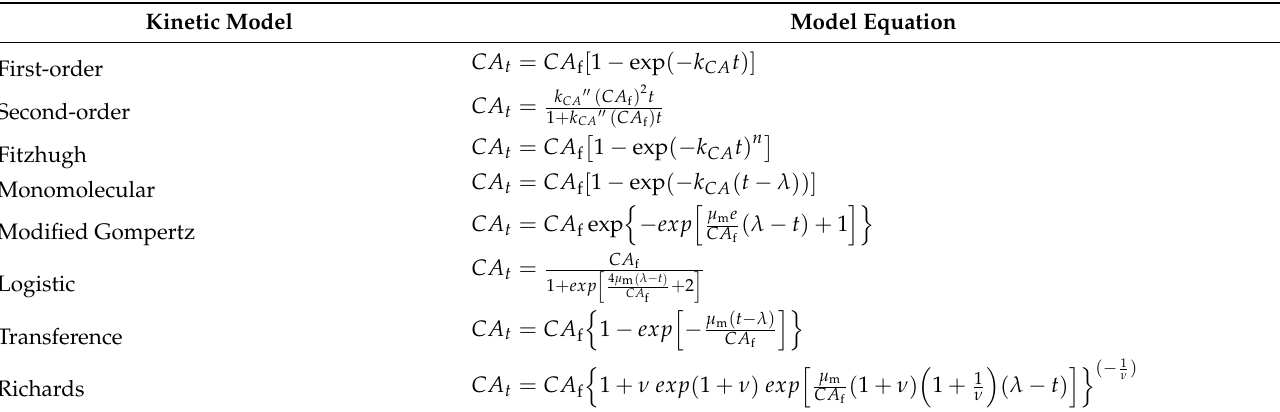
Table 2. Kinetic models selected to describe VFAs